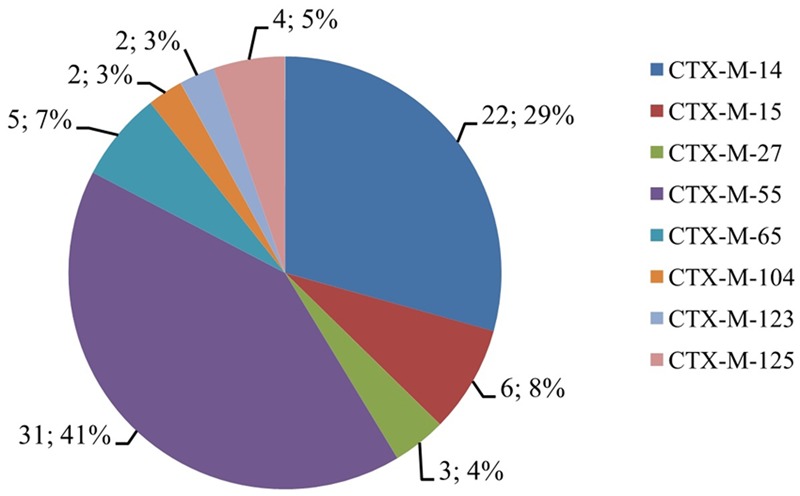
The CTX-M proportions of cephalosporin-resistant S. Typhimurium isolates. The digit before “;” indicates the number of isolates that contained blaCTX-M genes, and the digit after “;” indicates the percentage of isolates that contained blaCTX-M genes.